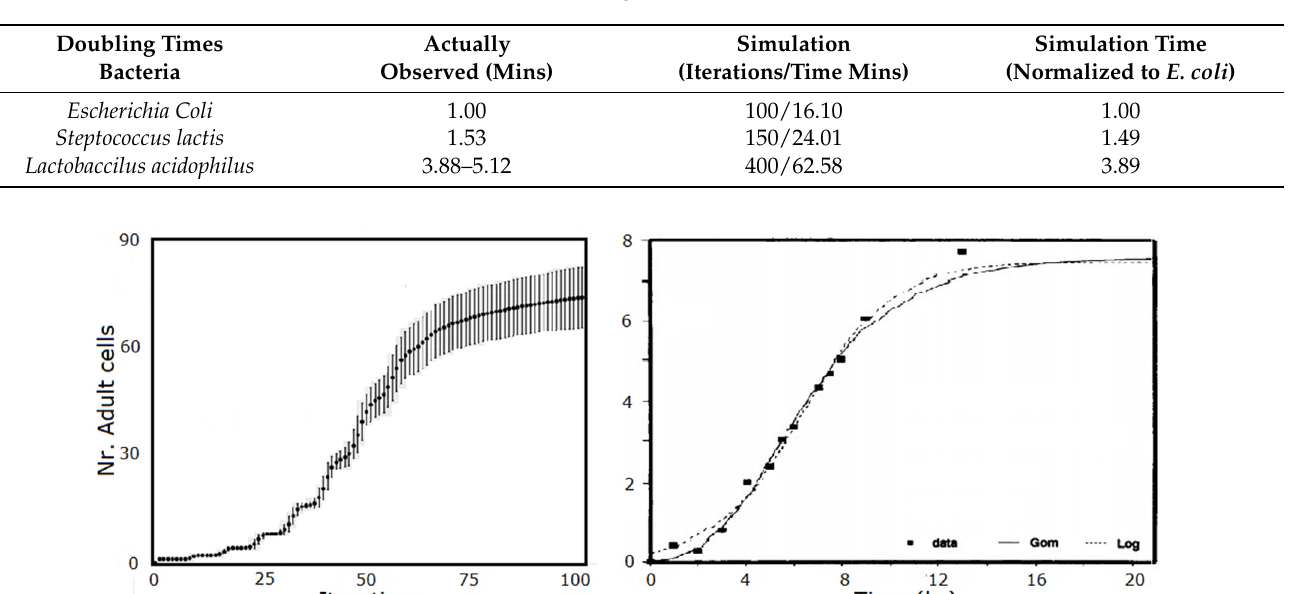
Table 1. Doubling time of a sample of three species of living bacteria [42].